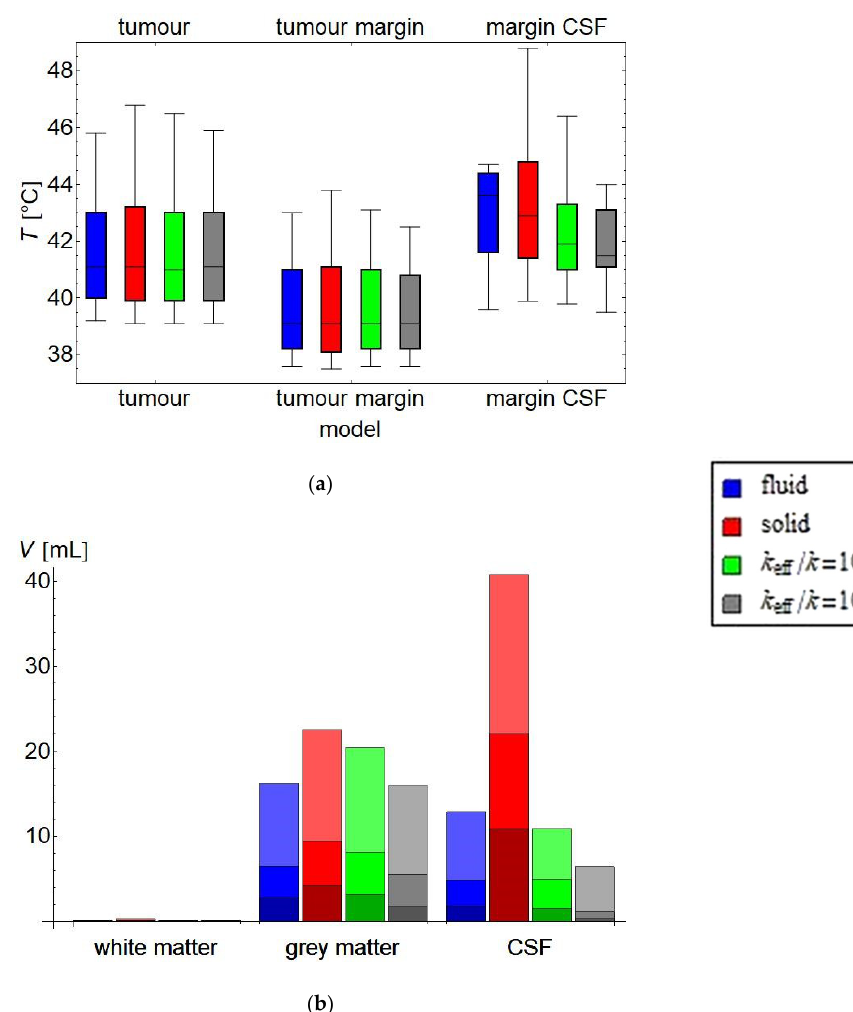
Figure 7. Analysis of treatment plan parameters for the post-operative case. ( a ) shows the temperature distribution in the treatment target: box: inter-quartile range with median temperature T 50 indicated; whiskers: T 90 and T 10 , i.e., the temperature exceeded by, respectively, 90% and 10% of the volume. For the treatment target, a temperature in the range 42–43 °C is clinically considered optimal. ( b ) shows for the healthy tissue the volume exceeding, respectively, 41, 42 and 43 °C (a darker shade representing a higher temperature). Clinically, these volumes should be as low as possible. Total volume: white matter = 125 mL; grey matter = 1007 mL; CSF = 340 mL; tumour = 92 mL. The exact numbers are provided in Table S1.